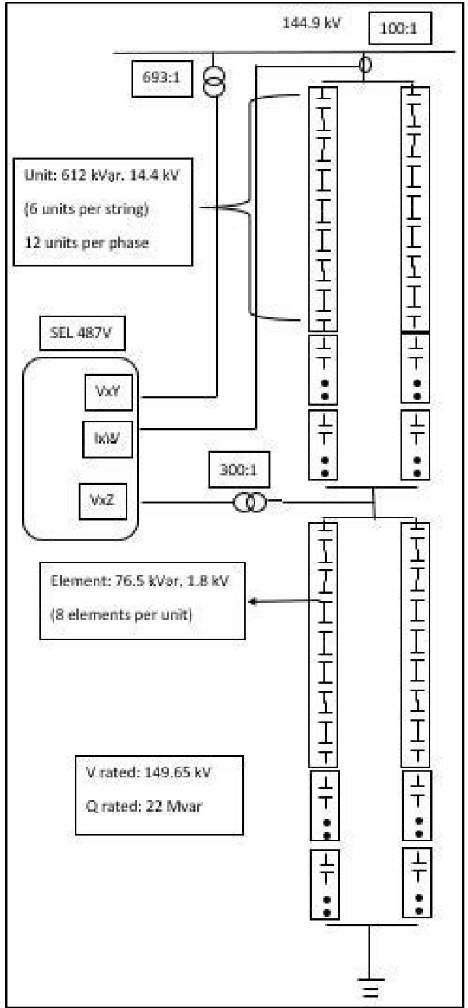
Figure 2. A power system with a capacitor bank configuration is being investigated.